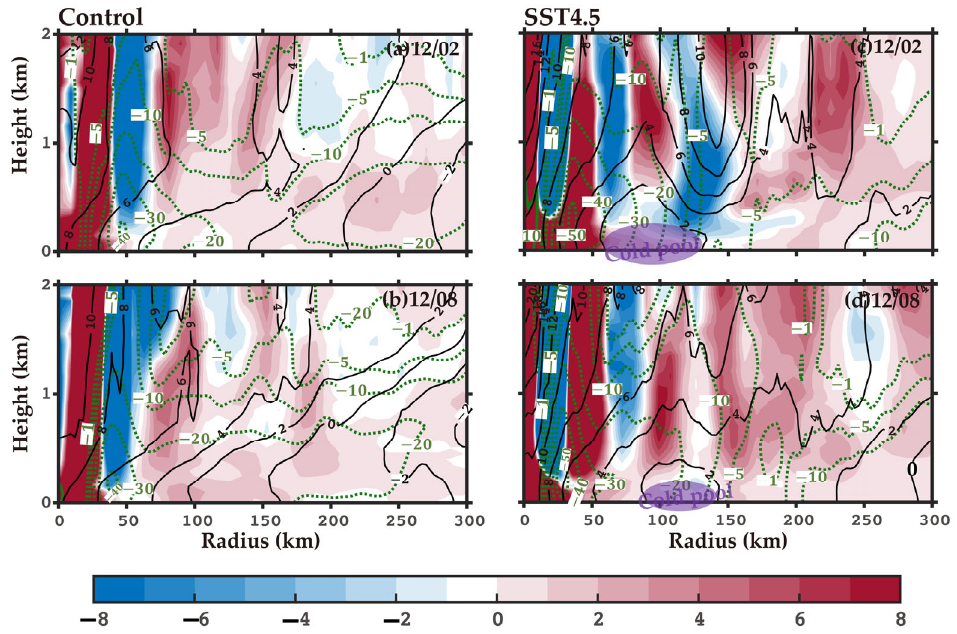
Figure 8. Radius–height cross-section of potential temperature departure (black contours; 2 K interval; from D3 output), radial velocity (green contours; m s − 1 ; positive values are solid for outflow, and negative values are dotted for inflow; from D3 output), and scalar frontogenesis function (shaded; 10 − 8 K m − 1 s − 1 ; positive values indicate frontogenesis, and negative values indicate frontolysis; the D2 output is utilized) at ( a ) 12/02 and ( b ) 12/08 in the control. ( c , d ) As in ( a , b ) but for SST4.5. The variables are azimuthally averaged over the segments that are indicated by two dark blue lines in Figures 6e and 10c. The purple words “cold pool” and shadows indicate their approximate locations; 12/02 is chosen to represent stage 2a, and 12/08 is chosen to represent stage 2b.